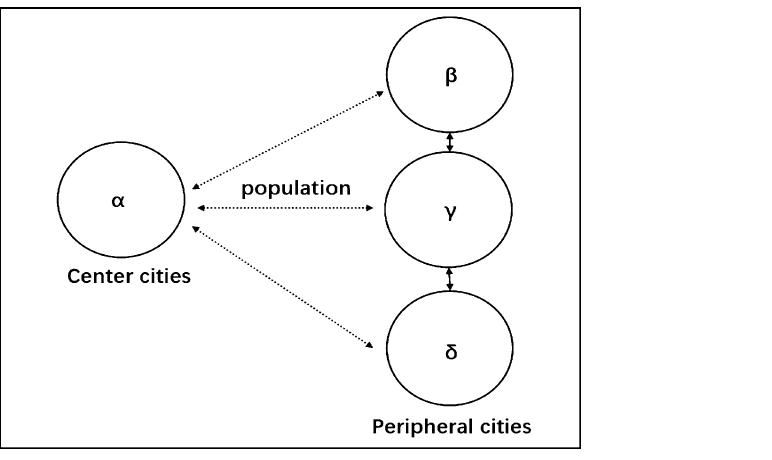
Figure 3. Population migrates among